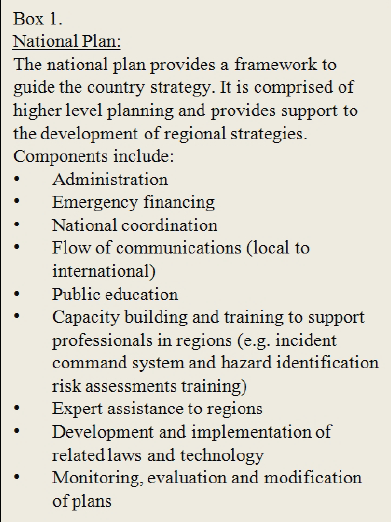
Figure 1. Description of the objectives of a national preparedness plan with examples of components.